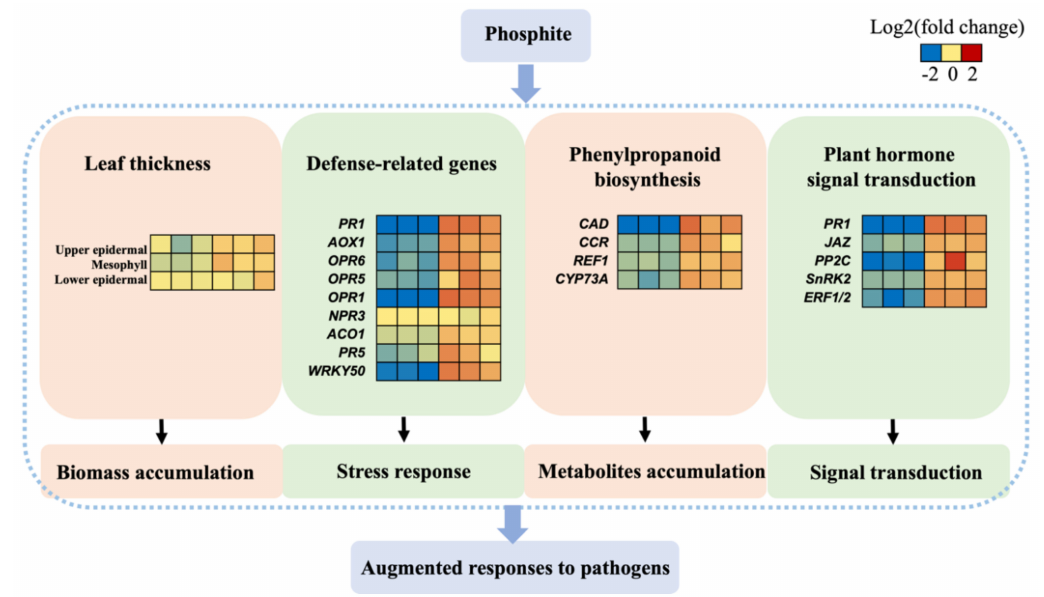
Figure 5. A predicted model of augmented responses of pathogens attack after PHI treatment. The intensity of orange and blue colors indicates the extent of induction and repression, respectively. For each heatmap, the first three columns are the controls and from fourth to sixth are the PHI-treated